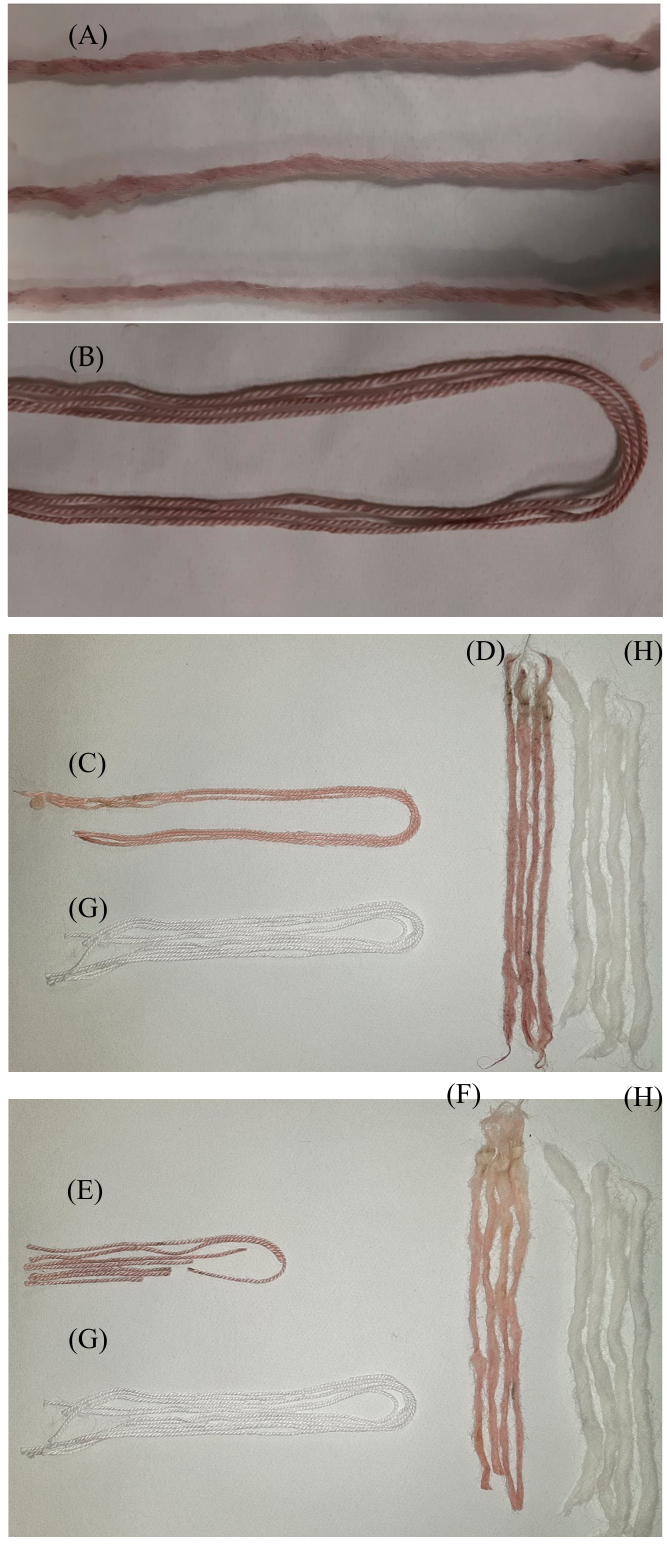
Figure 4. Series of pictures of the dyed fibers with and without mordanting. (A) The cotton and (B) wool without mordanting; (C) the cotton and (D) wool mordanting with lemon juice; (E) the cotton and (F) wool mordanting with aluminum potassium sulphate. The controls appear and are represented with letter (G) and (H) for the cotton and wool fibers, respectively.